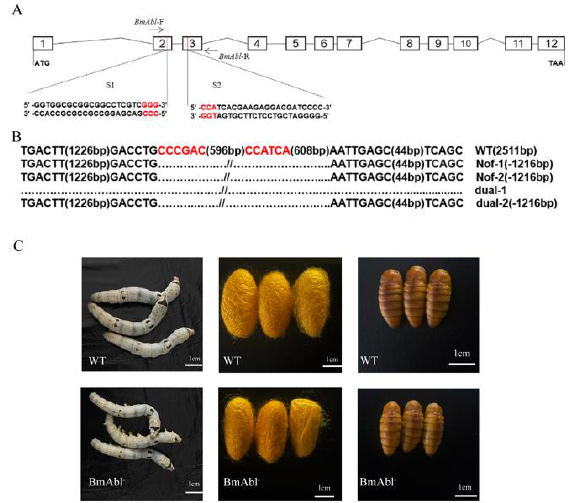
Figure 2. Target site design of CRISPR/Cas9 and verification. ( A ) Two target sites were designed on BmAbl1 . One is on the second exon; another is on the third exon; ( B ) sequencing results show that the fragment has been deleted between two target sites; WT indicates Nistari strain. Dual-1 and dual-2 are BmAbl1 defective strains based on CRISPR/Cas9 method. Nof-1 and nof-2 are BmAbl1 defective strains that removed fluorescence protein from the genome through cross-fertilizing with Nistari and self-fertilizing. ( C ) Developmental change of bombyx larvae and pupa between WT and BmAbl - . BmAbl1 - strain showed smaller individual (average 0.73 g) and cocoon size (average 0.96 g) than wide type (average 1.00 g, 1.15 g, respectively) (scale bar, 1